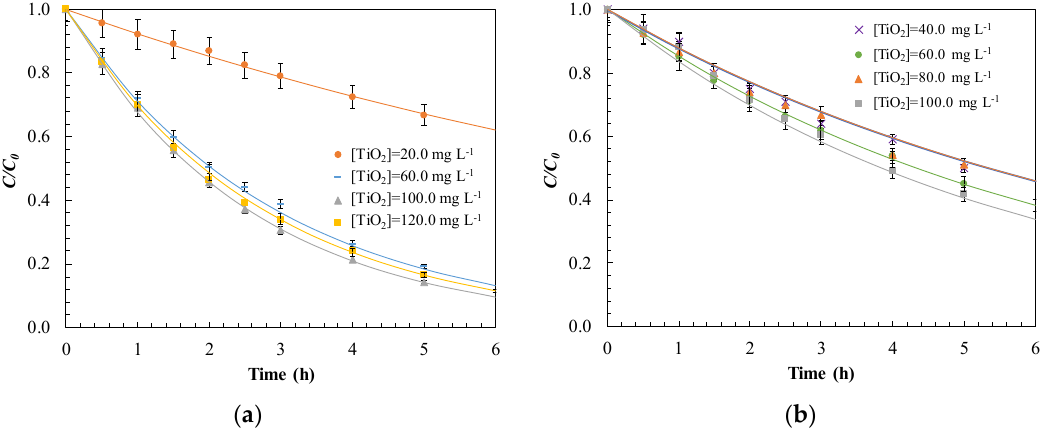
Figure 8. Experimental (dots) and pseudo-1st-order modelled ( ——— ) kinetic results for photocatalytic degradation of: ( a ) aniline operating at pH = 12.0 or ( b ) benzothiazole operating at pH = 8.0 carrying out the treatment in a hybrid system with supported catalyst of TiO 2 and different doses of TiO 2 in suspension simultaneously. Experimental conditions: C 0 = 22.0 mg L −1 ; T = 25.0 °C; P = 1.0 atm.